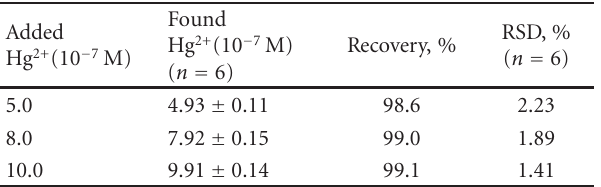
Table 2: Determination of Hg2+ in artificial seawater samples by DPV at